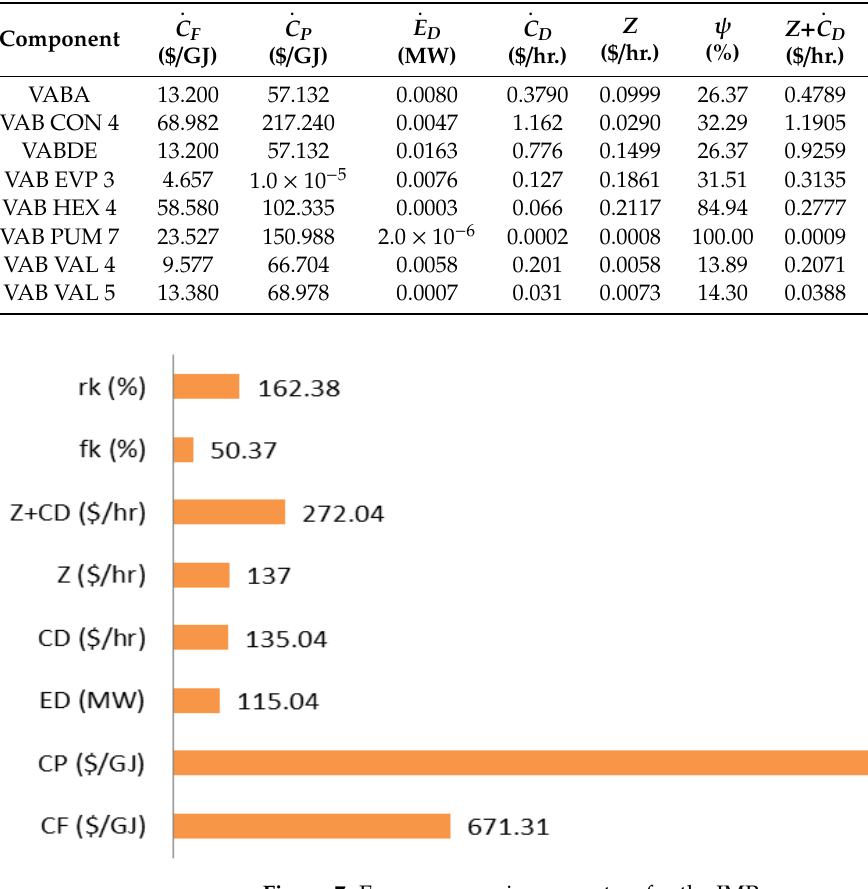
Figure 7. Exergoeconomic parameters for the IMP.